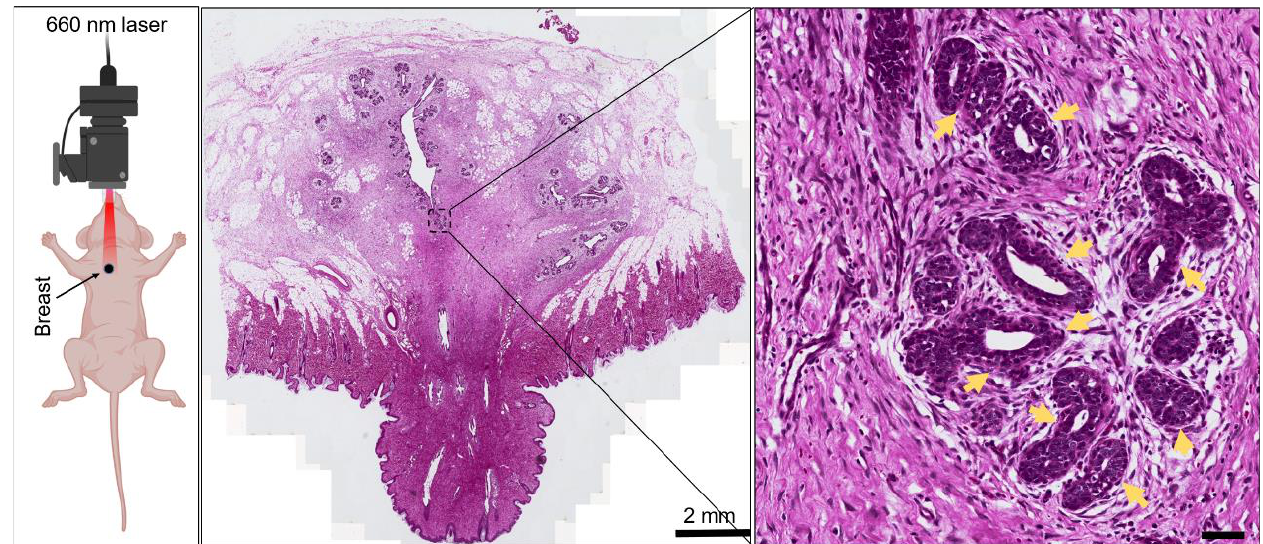
Figure 1. Diagram of mouse breast ( n = 3 replicates) with exposure to 660 nm laser (power, 10 mW; total light dosage, 10 J/cm 2 ). The exposed breast tissue was obtained, and H&E staining was conducted to examine the morphological changes post treatment. Scale bar is 2 mm and 50 μ m, respectively.